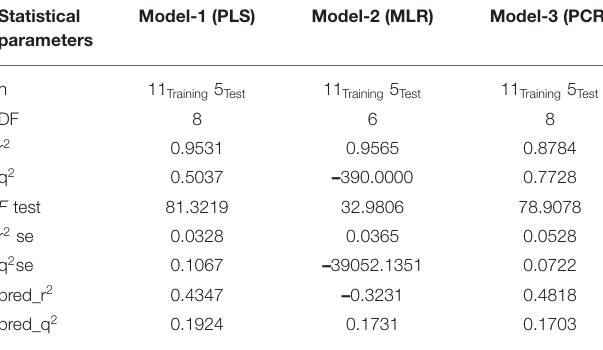
Table 4C | Statistical results of 2D-QSAR models against M. incognita .